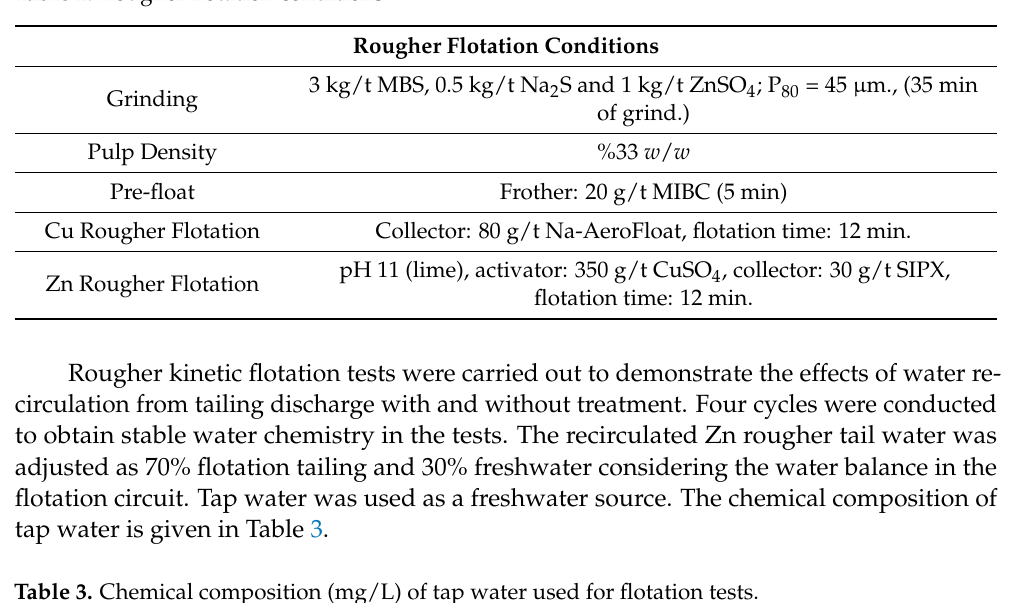
Table 2. Rougher flotation conditions.